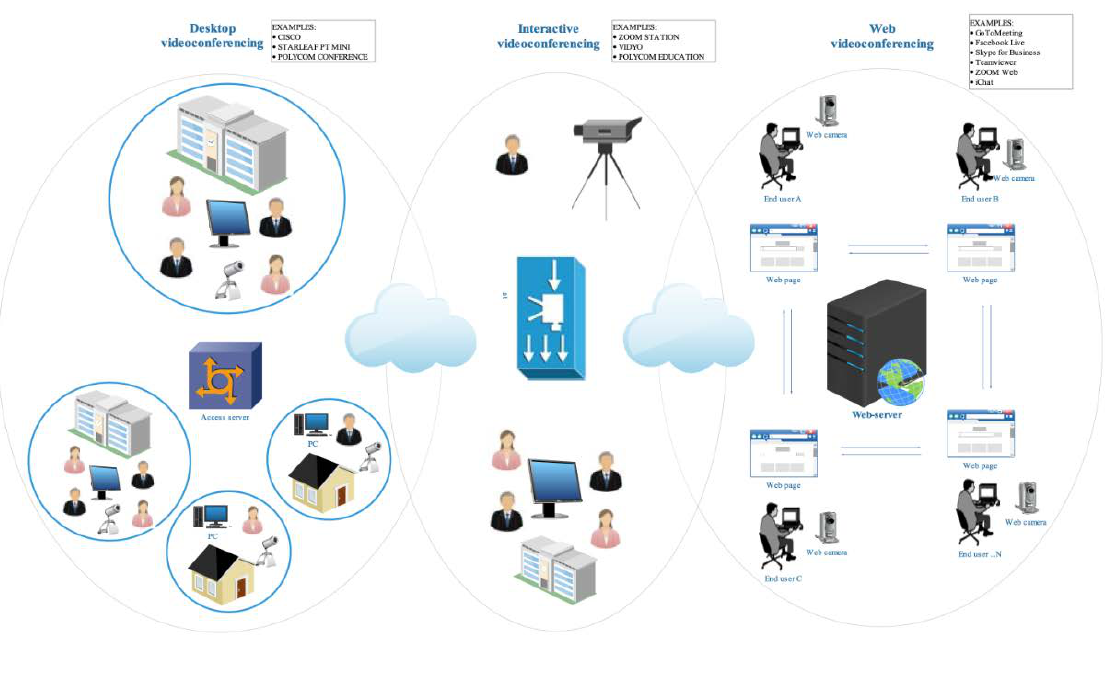
Figure 1 . An illustration of different videoconferencing